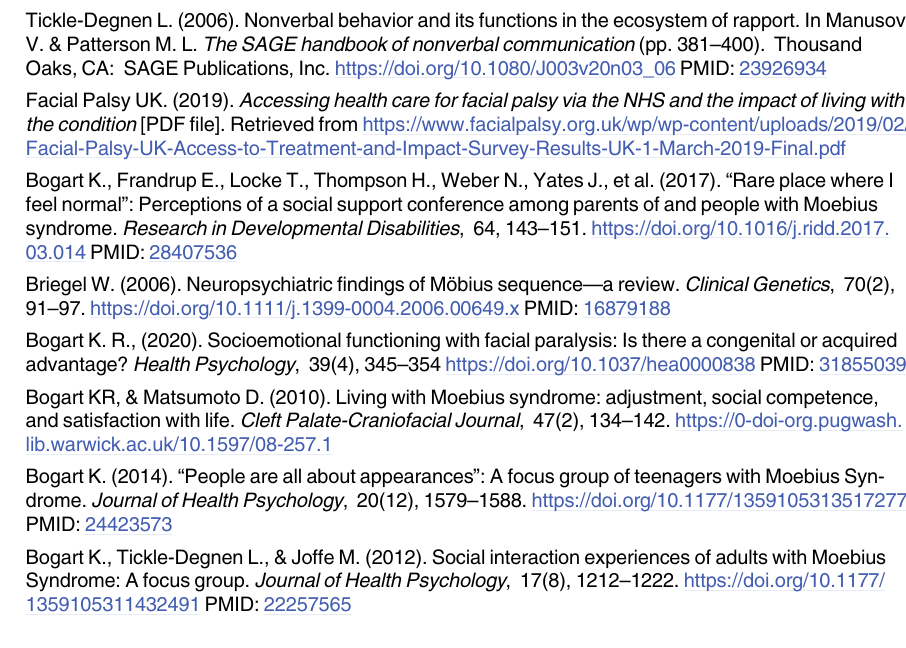
S1 Table. Demographics. Breakdown of demographic information and time to complete sur- vey across both conditions. S2 Table. Descriptives. Means (and standard deviations) of the main dependent variables tested in our